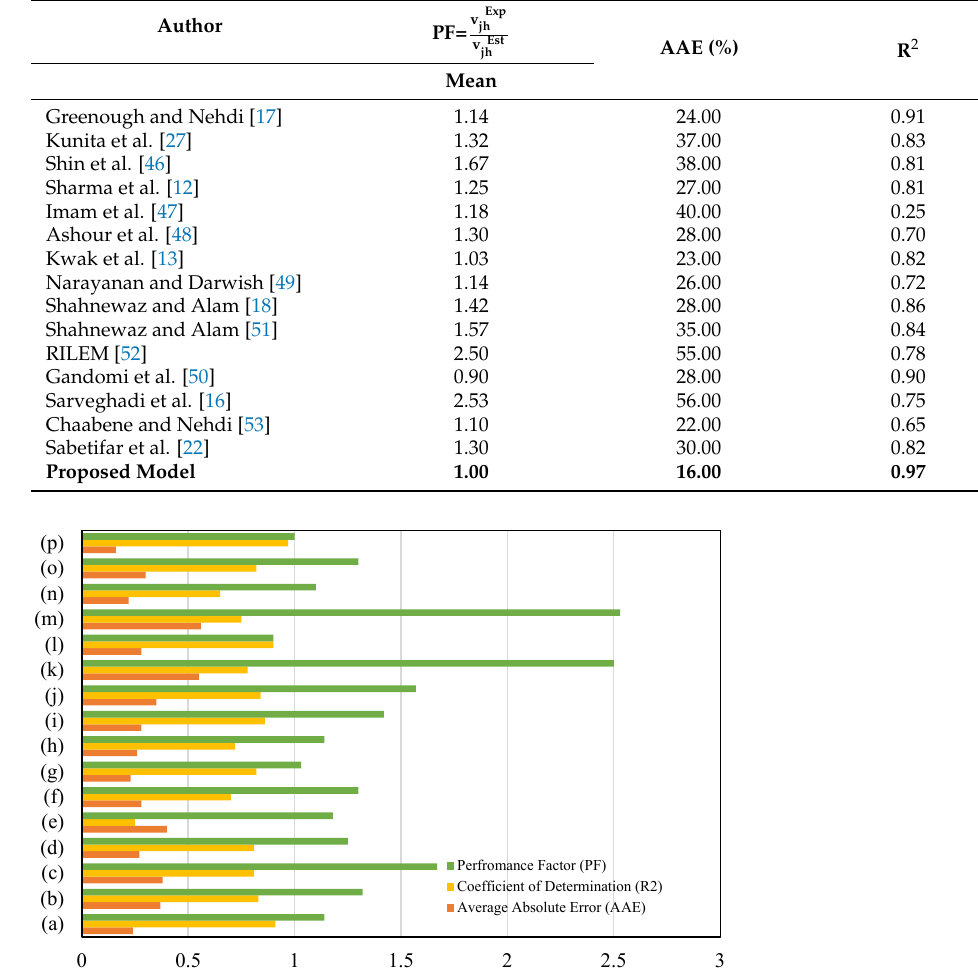
Figure 8. ( a ) Greenough and Nehdi [17], ( b ) Kunita et al. [27], ( c ) Shin et al. [46], ( d ) Sharma et al. [12], ( e ) Imam et al.[47], ( f ) Ashour et al.[48], ( g ) Kwak et al.[13], ( h ) Narayanan and Darwish [49],